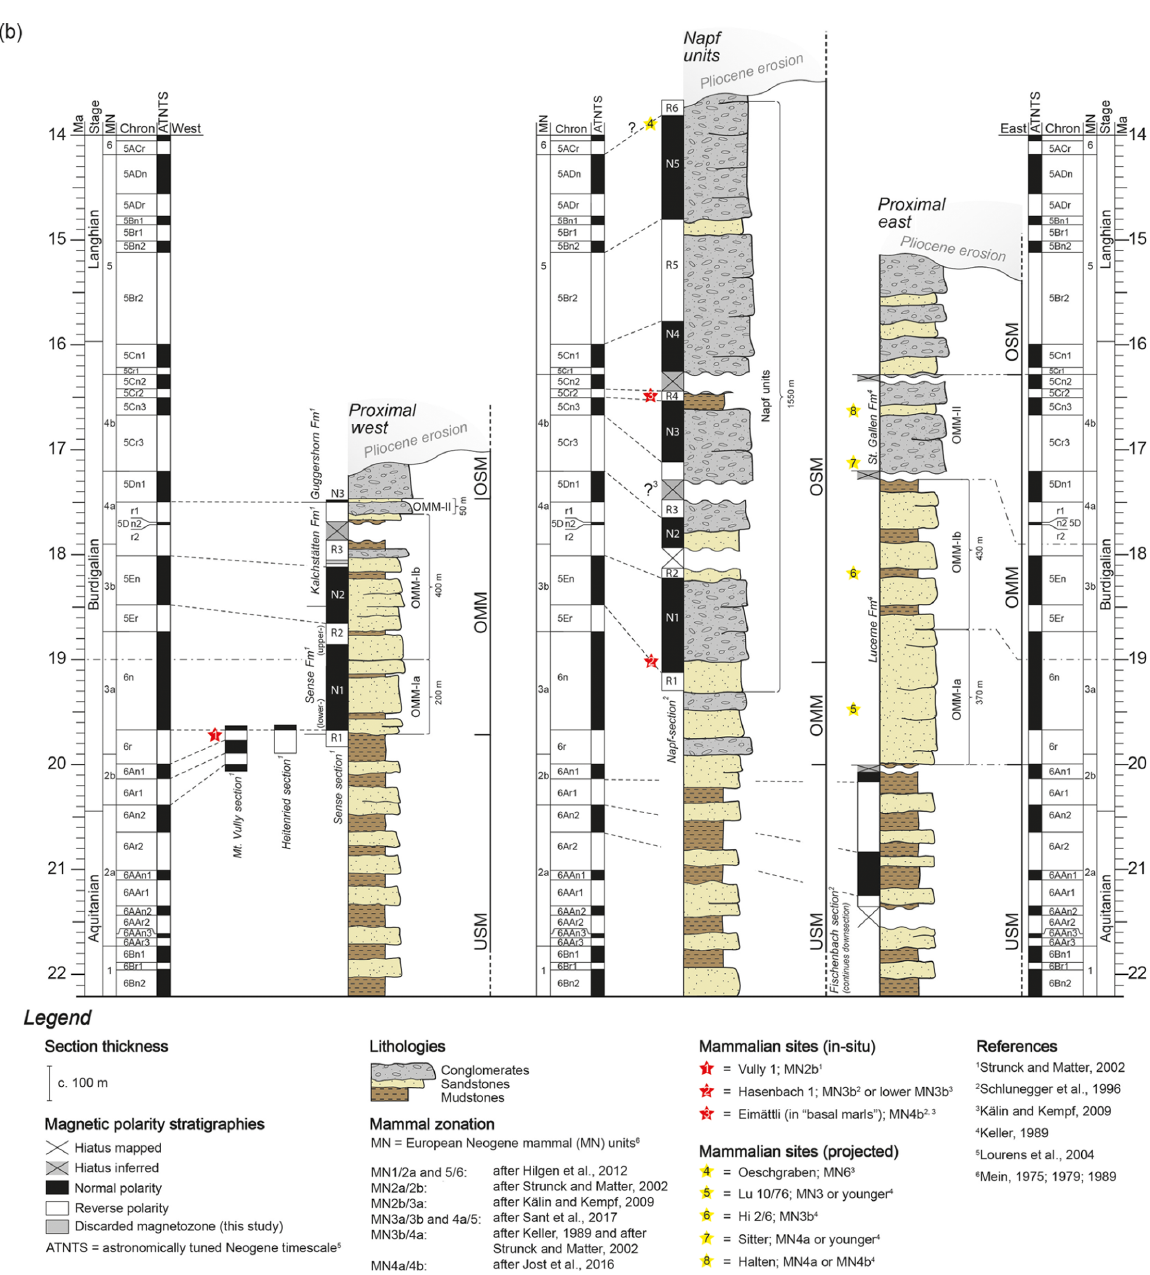
Figure 3. (a) Lithostratigraphic scheme of the OMM in Switzerland. (b) Composite stratigraphic columns illustrating sedimentary archi- tectures at the proximal basin border in the western Molasse basin (proximal west), in the central part of the Molasse basin (Napf units), and in the eastern basin (proximal east). The composite section for the proximal western basin is based on data from the Mt. Vully and Heitenried sections, drillings, and from surface information from the Sense section (Sense beds and Kalchstätten Formation) (Strunck and Matter, 2002). The composite section representative of the central part of the Molasse basin (Napf) is mainly based on the sedimentary logs by Schlunegger et al. (1996; see their Schwändigraben and Fontannen sections) complemented with information from the geological map of the region (Schlunegger et al., 2016). Note that Kälin and Kempf (2009) proposed a very short hiatus recorded by magnetozone R3 within the Napf units, which we do not discuss in detail for simplicity purposes. The composite section illustrating the situation at the proximal basin border east of the Napf represents the sedimentary architecture as far east as Lake Zurich (Fig. 2a). It is based on data from Keller (1989, see his Rümlig, Ränggloch, and Lucerne sections) and from Schlunegger et al. (1996, see their Fischenbach section) and geological maps of the region (Wolhusen; Isler and Murer, 2019). Note that the Entlen section is situated immediately east of the Napf (Fig. 5a) where the lowermost part (Lucerne Formation) can be characterized by the composite section of the proximal east. Detailed sedimentological data of the Sense Formation and the Lucerne Formation are shown in Fig. 4. Note that the Molasse units shown in capitals (i.e. USM, OMM, and OSM) are based on the lithological architecture and thus on facies associations identified in the field. Solid Earth, 10, 2045–2072, 2019